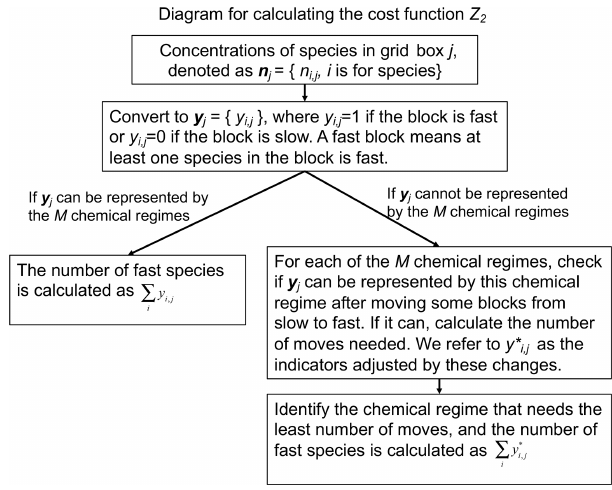
Figure 1. The diagram for calculating the cost function Z 2